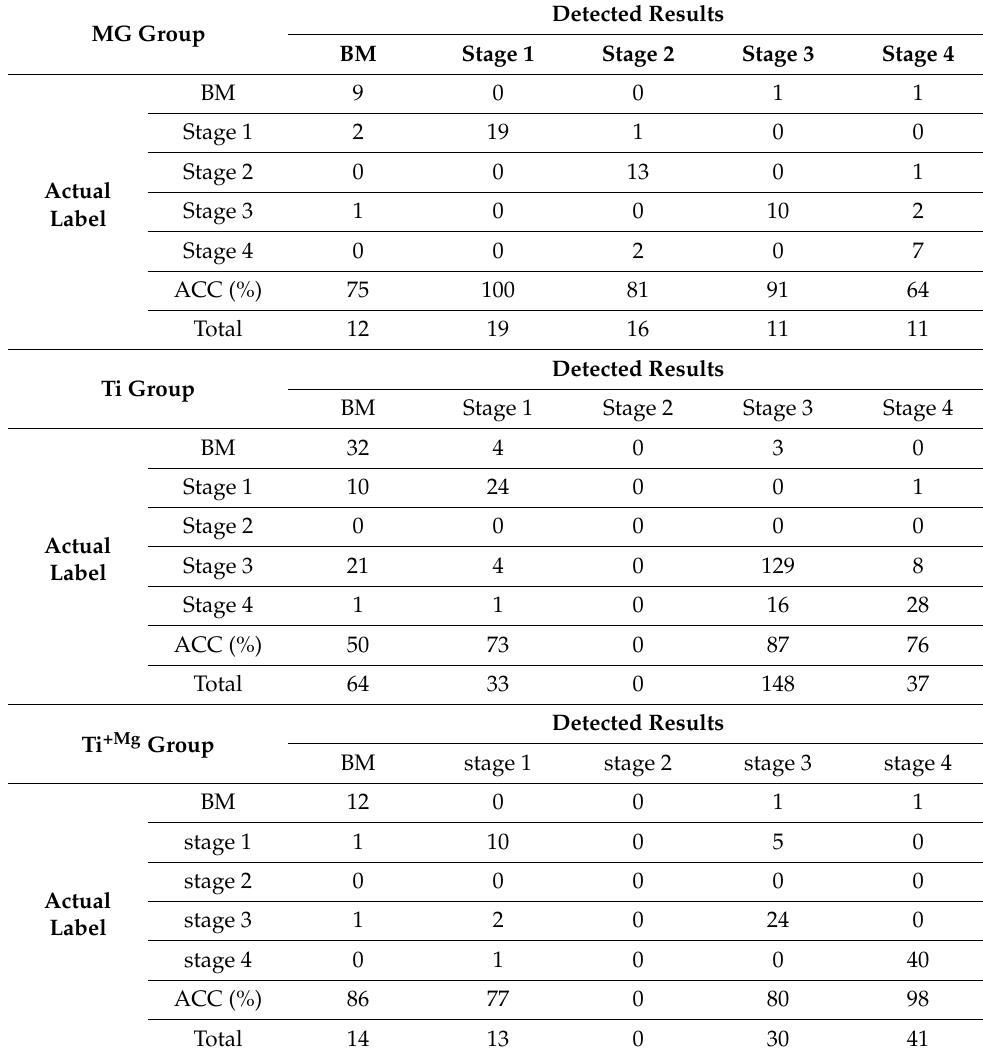
Table 3. Confusion matrix for biofilm classification using the proposed CNN model for Mg, Ti and Ti +Mg groups,